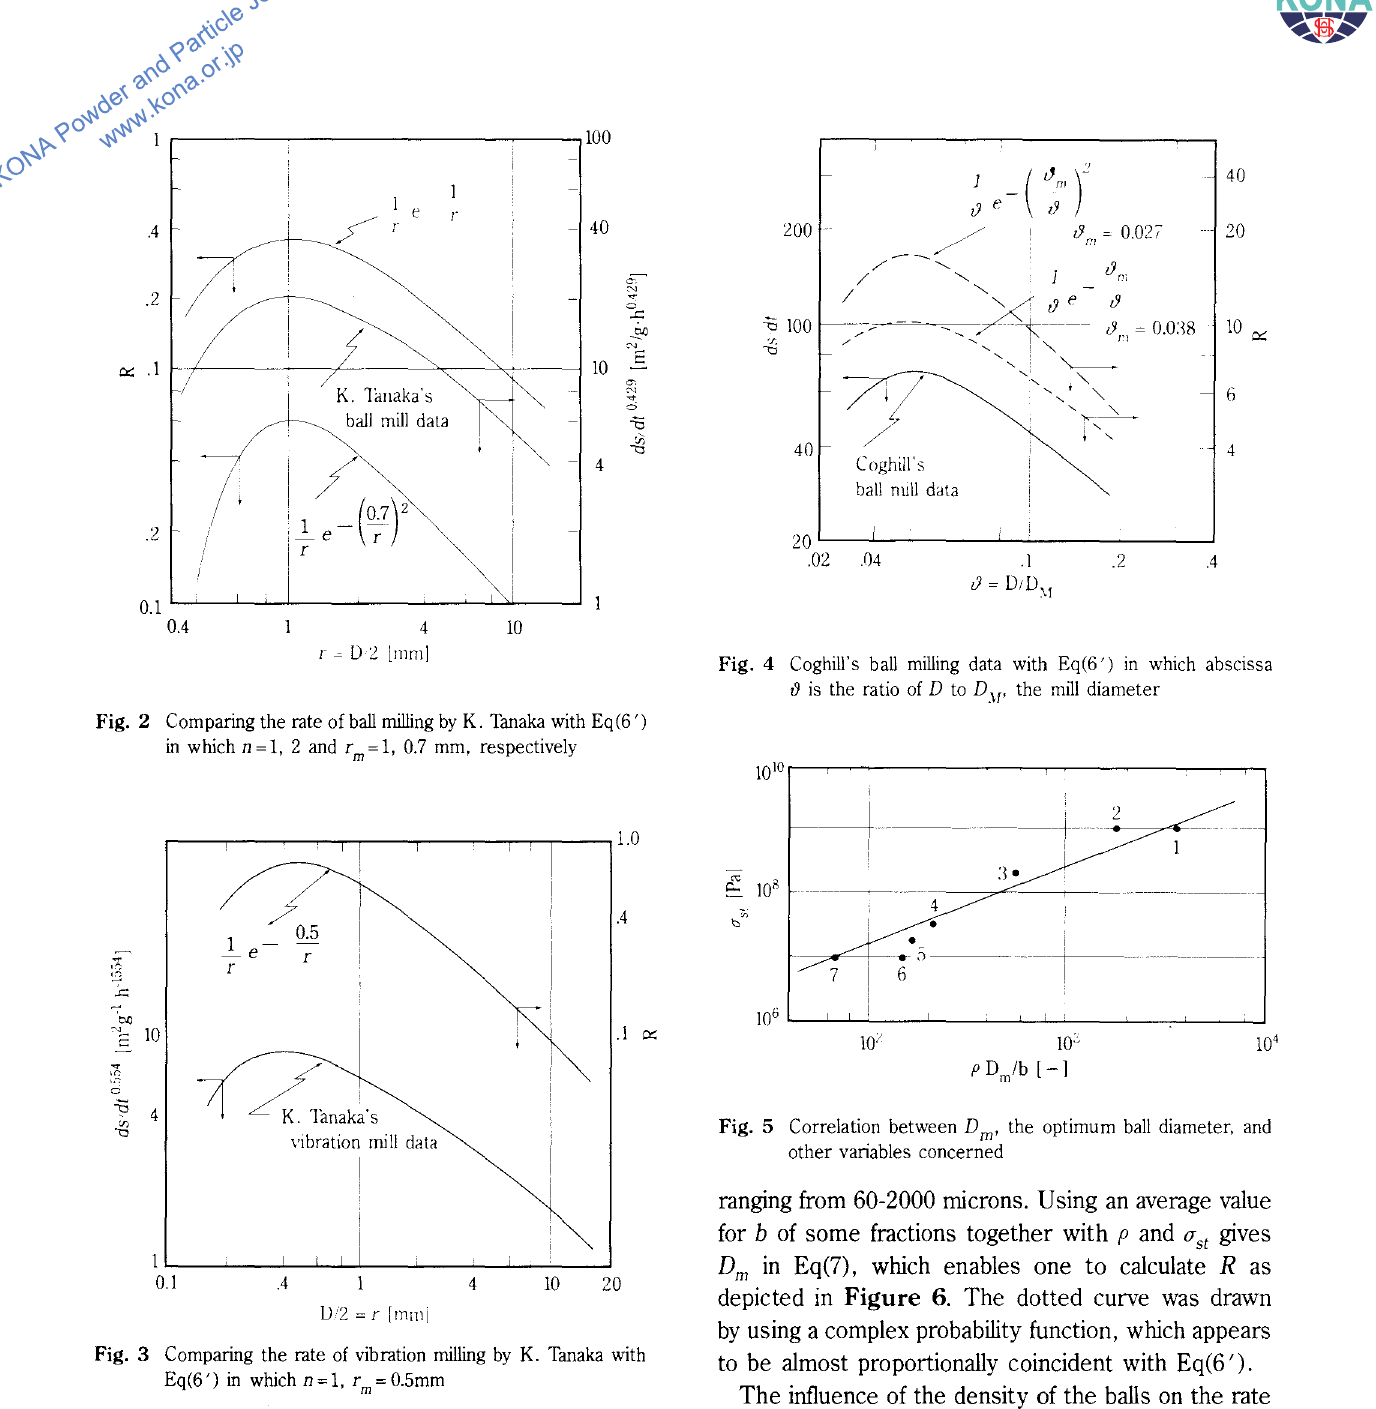
Fig. 3 Comparing the rate of vibration milling by K. Tanaka with Eq(6 ') in which n = 1, r m = 0.5mm for each experiment in Table 1, an important correla tion is found as shown in Figure 5, from which we have, regardless of the type of mills. 4 l